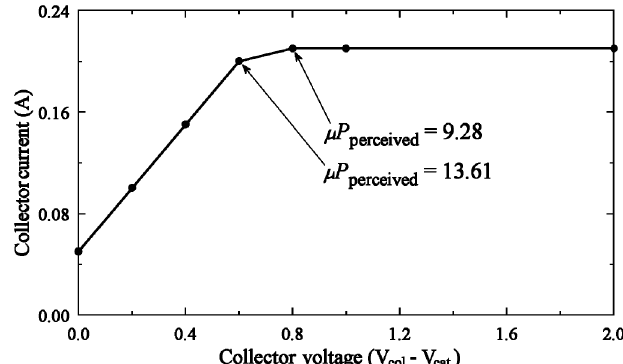
FIG. 15. Measurement of the collector acceptance. As the collector voltage is adjusted with respect to the cathode voltage, the current admitted to the collector